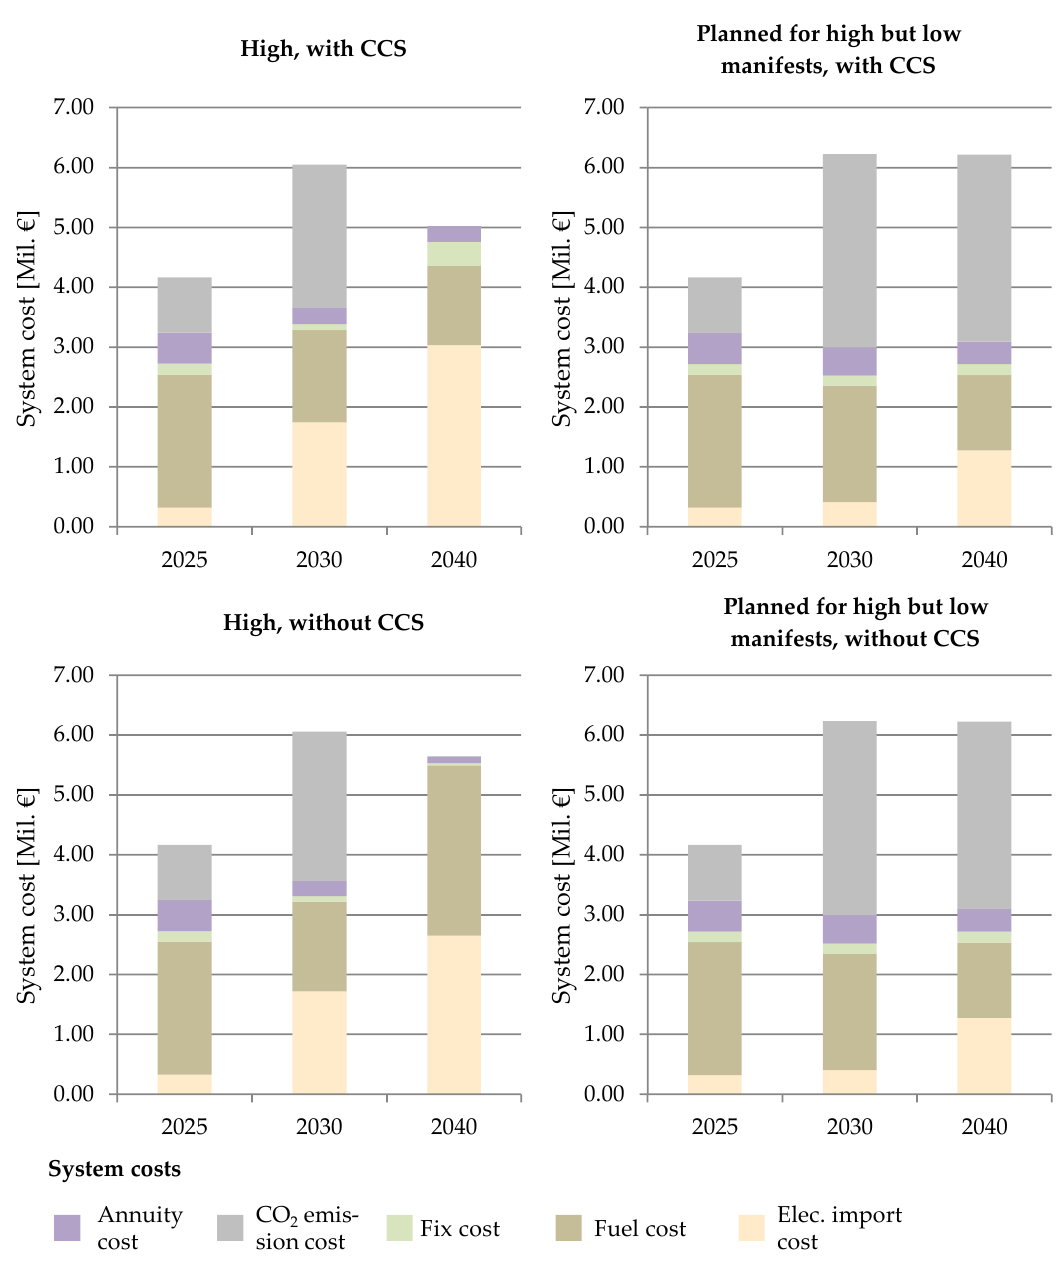
Figure 14. Cost structure of the high and “planned for high but low manifests” scenarios (myopic, with and without CCS).